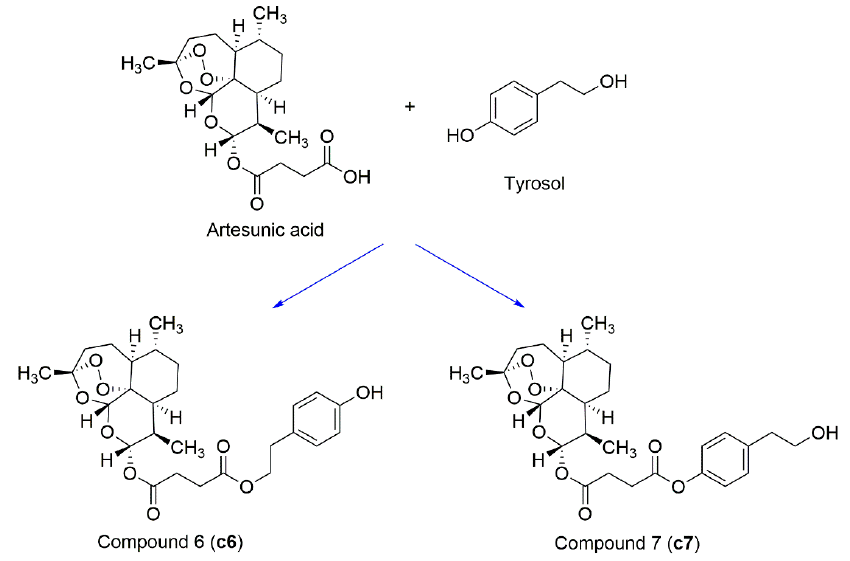
Figure 1. Chemical structure of c6 and c7 compounds.